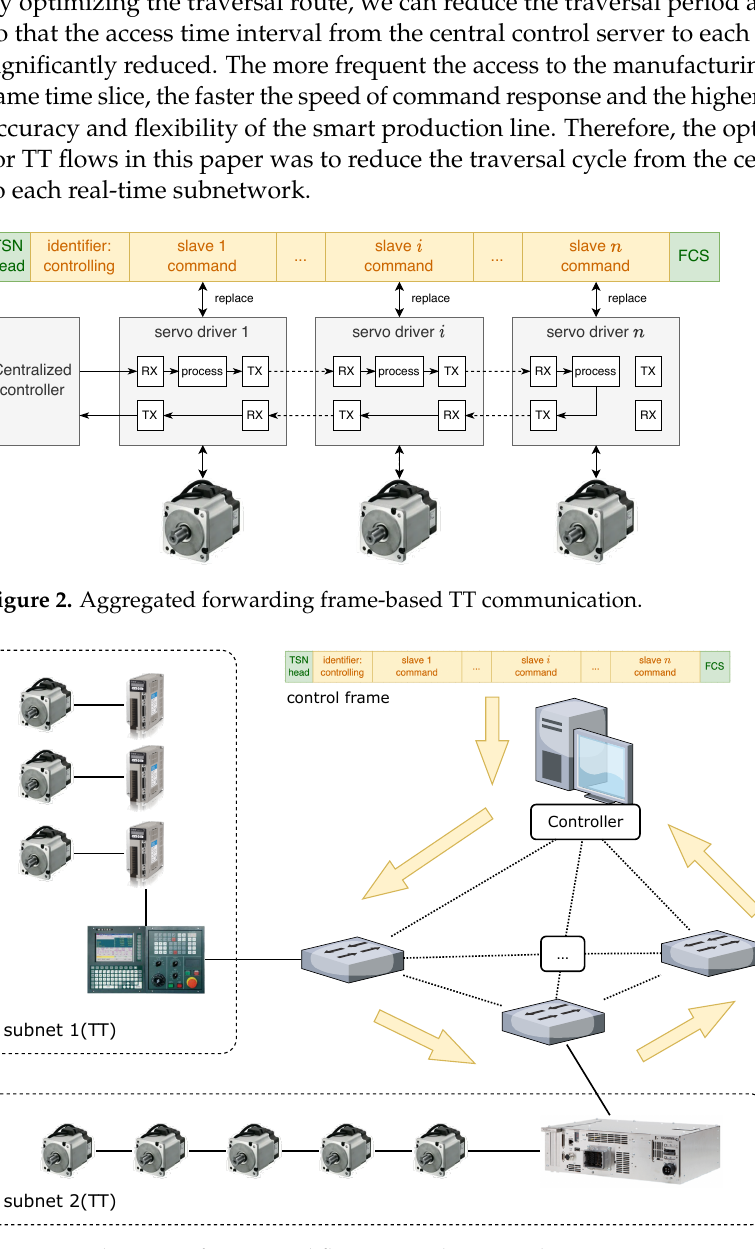
Figure 3. Schematic of TT control flow network